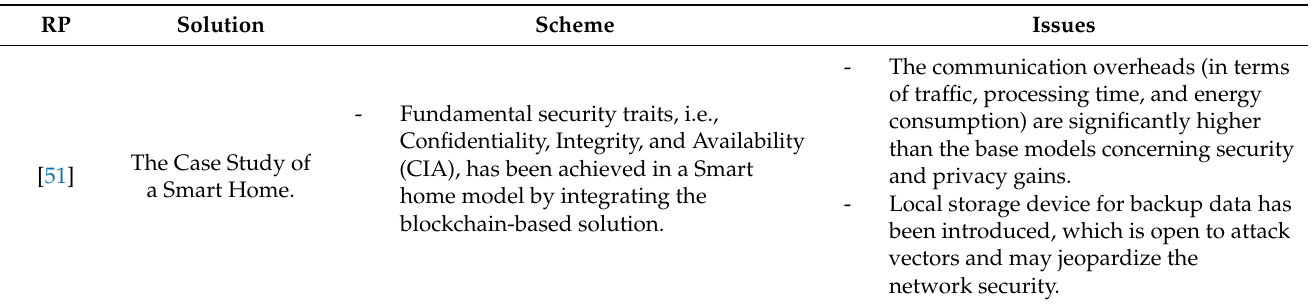
Table 2. IoT-Enabled Smart Device Authentication Schemes based on Distributed Architecture for Smart